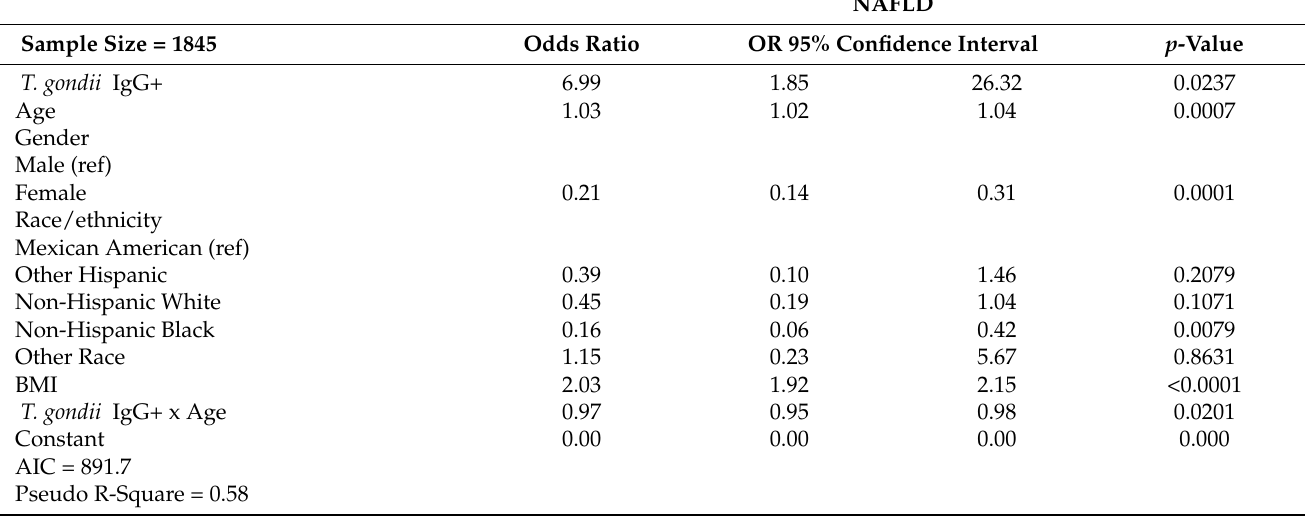
Table 10. US-FLI per T. gondii (IgG+/IgG − ). Table 11. Results of binomial logistic regression for NAFLD on T. gondii (IgG+/IgG − )—adjusted for BMI and demographic